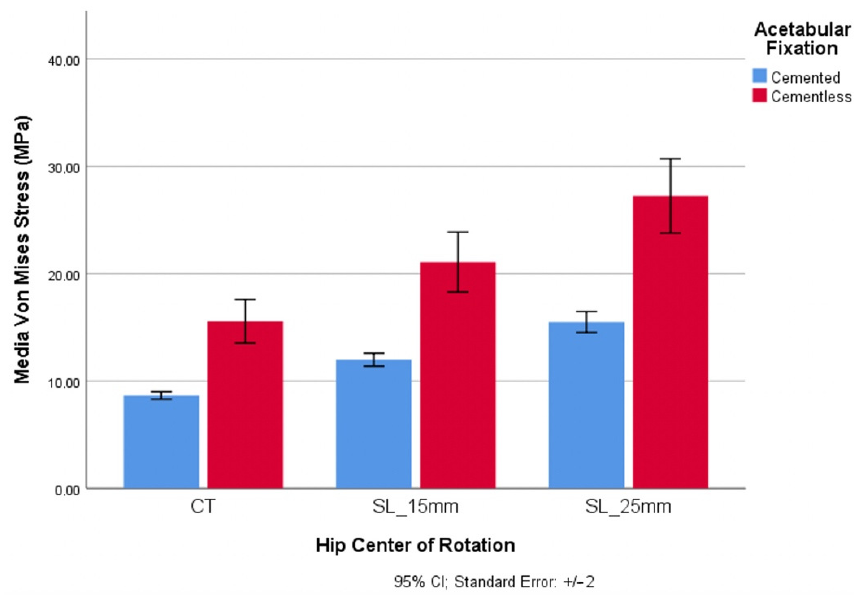
Figure 6. Wear risk through von Mises stress and hip center of rotation positioning: CT = anatomical position; SL_15 = superior lateralization with 15 mm vertical and horizontal distance from CT; SL_25 = superior lateralization with 25 mm vertical and horizontal distance from CT.